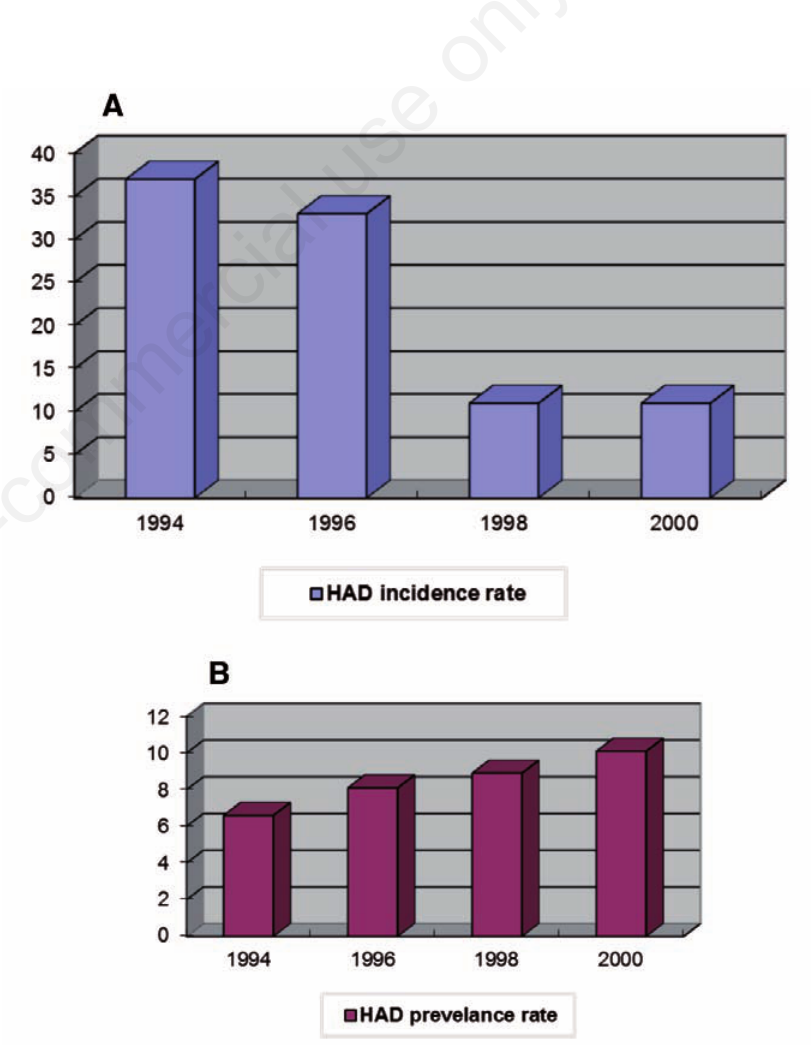
Figure 1. Incidence rate (A) and prevalence rate (B) of HAD in the Johns Hopkins HIV clinic. The x -axis corresponds to the calendar year. The y -axis corresponds to the incidence rate/prevalence rate per 1000 person